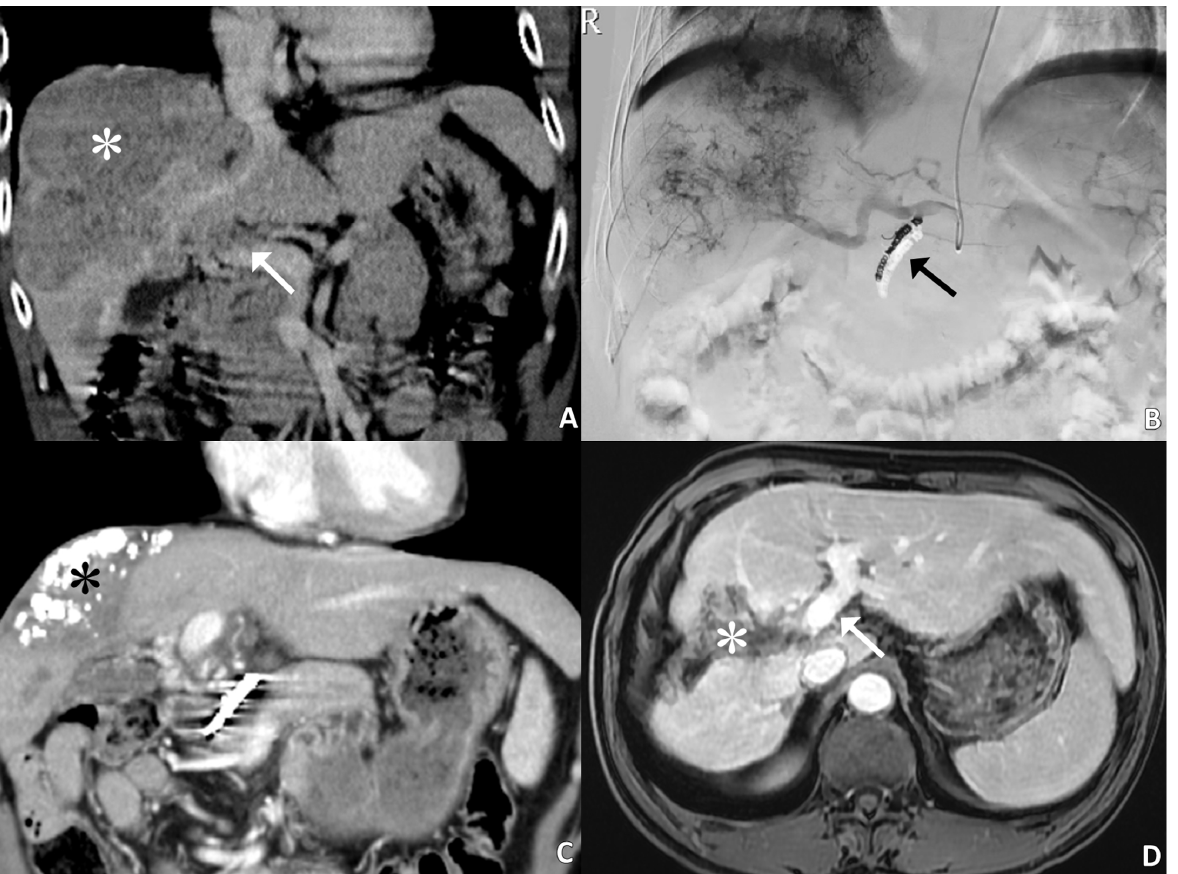
Figure 2. A 55-year-old male patient with complete response after five cycles of HAIC. ( A ): Coronal CT image shows a large HCC (white asterisk) in the right lobe of the liver with main portal venous tumor thrombosis (arrow). The initial serum AFP level is 35,678 ng/mL. ( B ): Hepatic angiogram reveals large tumor burden. The gastroduodenal artery is em- bolized with microcoils (arrow). ( C ): Partial response is obtained after two cycles of HAIC treatment. The hyperattenuated region (black asterisk) within the tumor is lipiodol retention. ( D ): Follow-up MRI after 5 cycles of HAIC treatment shows tumor shrinkage with cystic necrosis and lipiodol retention (white asterisk) in addition to complete resolution of portal venous tumor thrombosis (arrow). The serum AFP level is 2.5 ng/mL, and the patient has survived for more than 3 years after initial diagnosis of advanced HCC with PVTT.